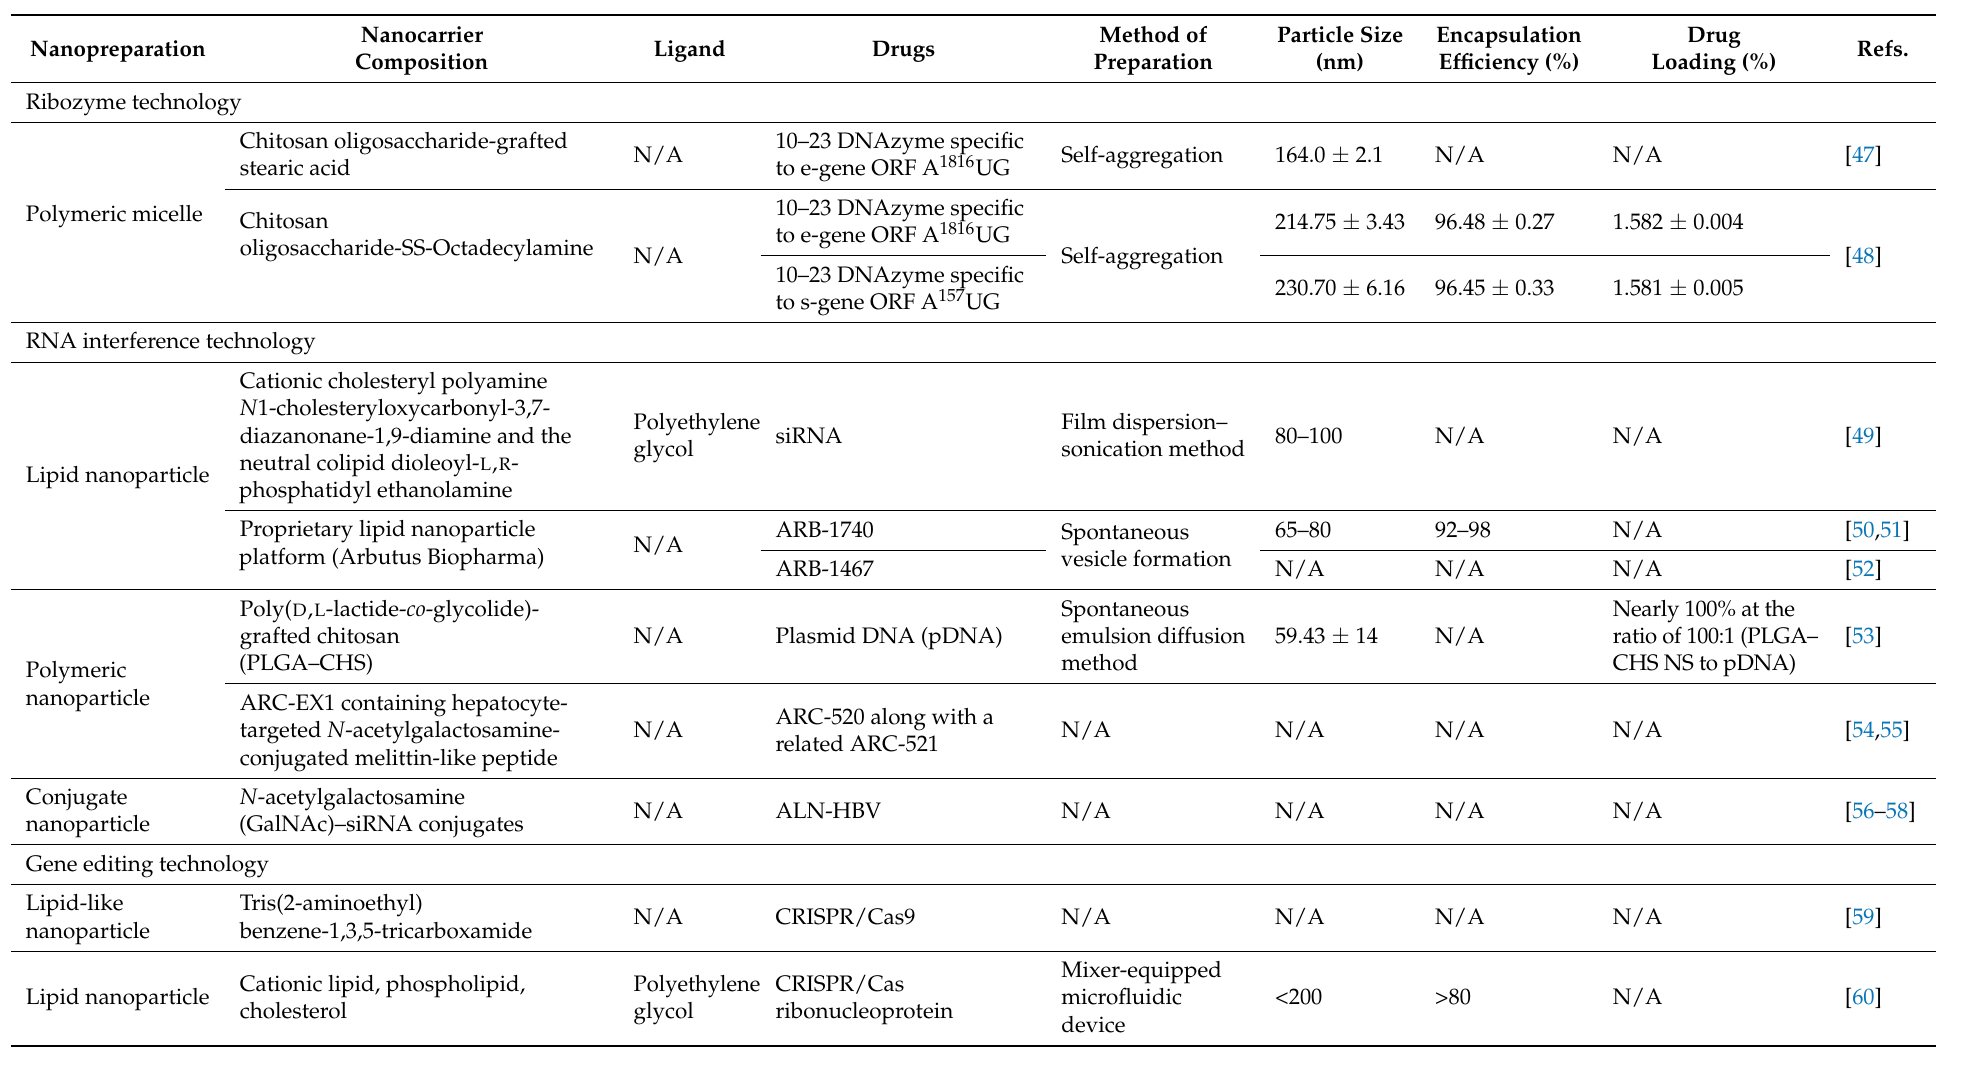
Table 2. Composition and properties of nanoparticle delivery systems for anti-HBV genetic